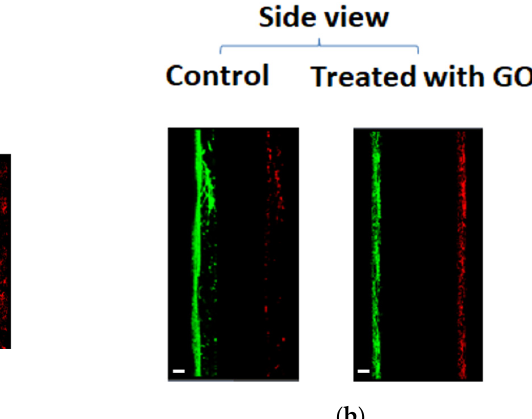
incubation with 320 mM NaCl. The biofilms were stained with SYTO 9 (left, green) and PI (right, red). ( a ) Top view ( b ) side view. Scale bar: 20 μ m.